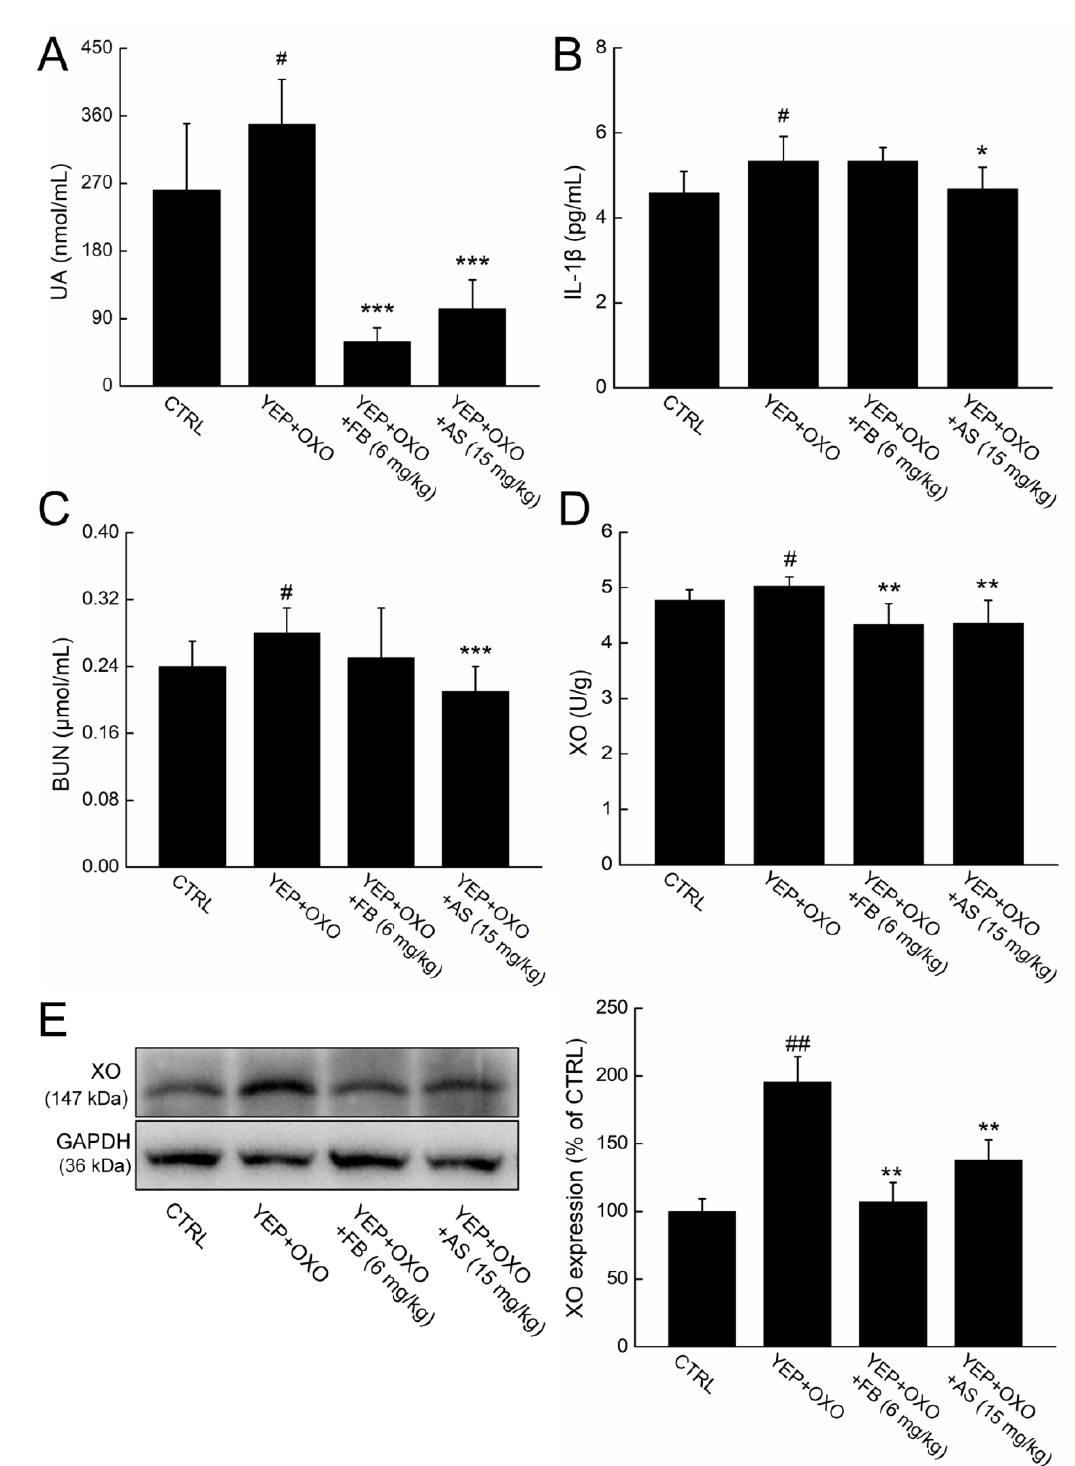
Figure 2: The therapeutic effects of AS on mice with hyperuricemia. In mice with hyperuricemia established via intragastrical administration with 20 g/kg of YEP for 8 days, and the intraperitoneal injection with 300 mg/kg of OXO, AS strongly reduced the serum levels of ( A ) UA, ( B ) IL-1β, ( C ) BUN and ( D ) XO level of hepatic. ( E ) AS reduced the XO expression in liver. The data of quantified protein expressions are normalized by GAPDH, analyzed using a one-way ANOVA and expressed as mean ± S.D. ( = 12). # P <0.05 and ## P <0.01 vs. CTRL mice. * P <0.05, ** P <0.01 and *** P <0.001 vs. vehicle treated mice with hyperuricemia. YEP, yeast extract powder; OXO, potassium oxonate; FB, febuxostat 𝑛 tablets; AS, astilbin; UA, uric acid; XO, xanthine oxidase; BUN, blood urine